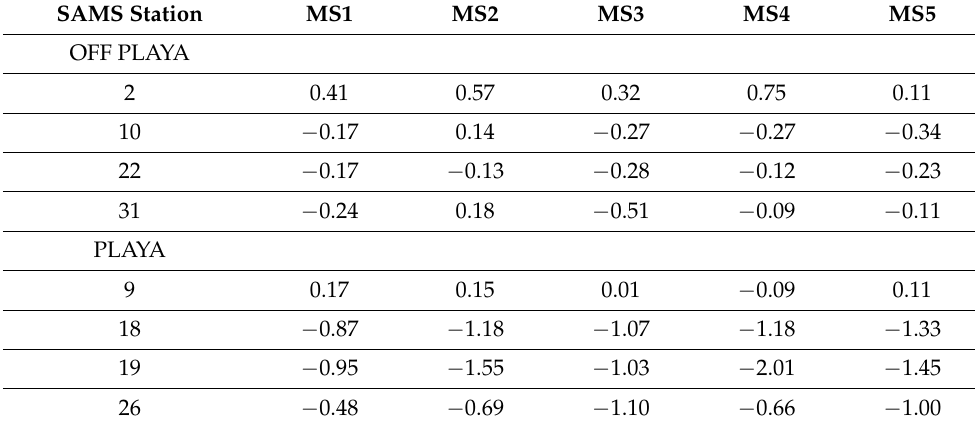
Table 6. Aggregate 10 m AGL v-wind component mean bias values for each model setup.